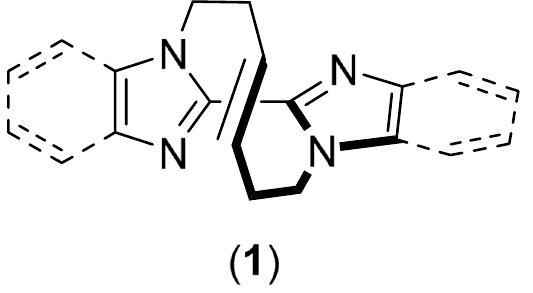
Figure 1. Structure of winding-vine-shaped heterobiaryl with molecular asymmetry.